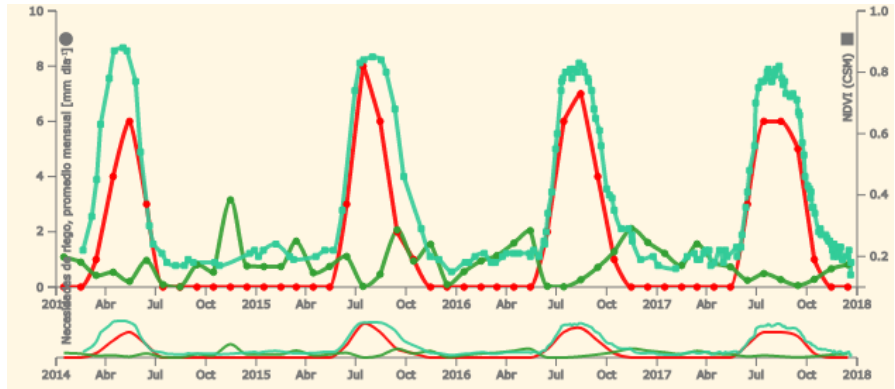
Figure 3. Monthly evolution of the time series of net irrigation water requirements (red chart) and precipitation (green chart), jointly with the NDVI time series (cyan chart) along 2014–2017.